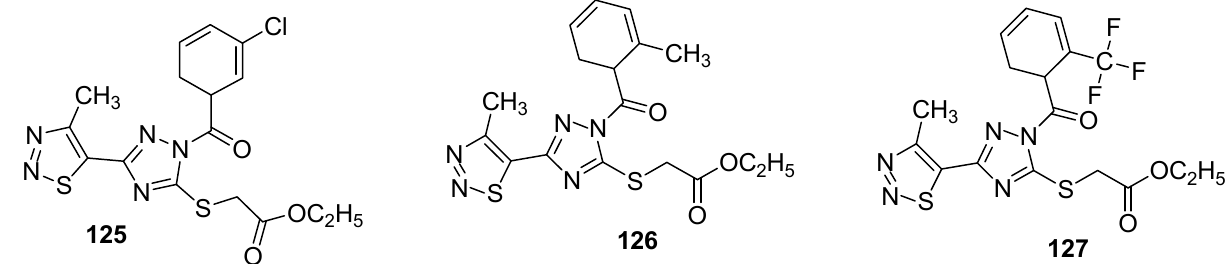
Figure 21. Substituted 4-methyl-1,2,3-thiadiazole derivatives with insecticidal properties against Aphis laburni .